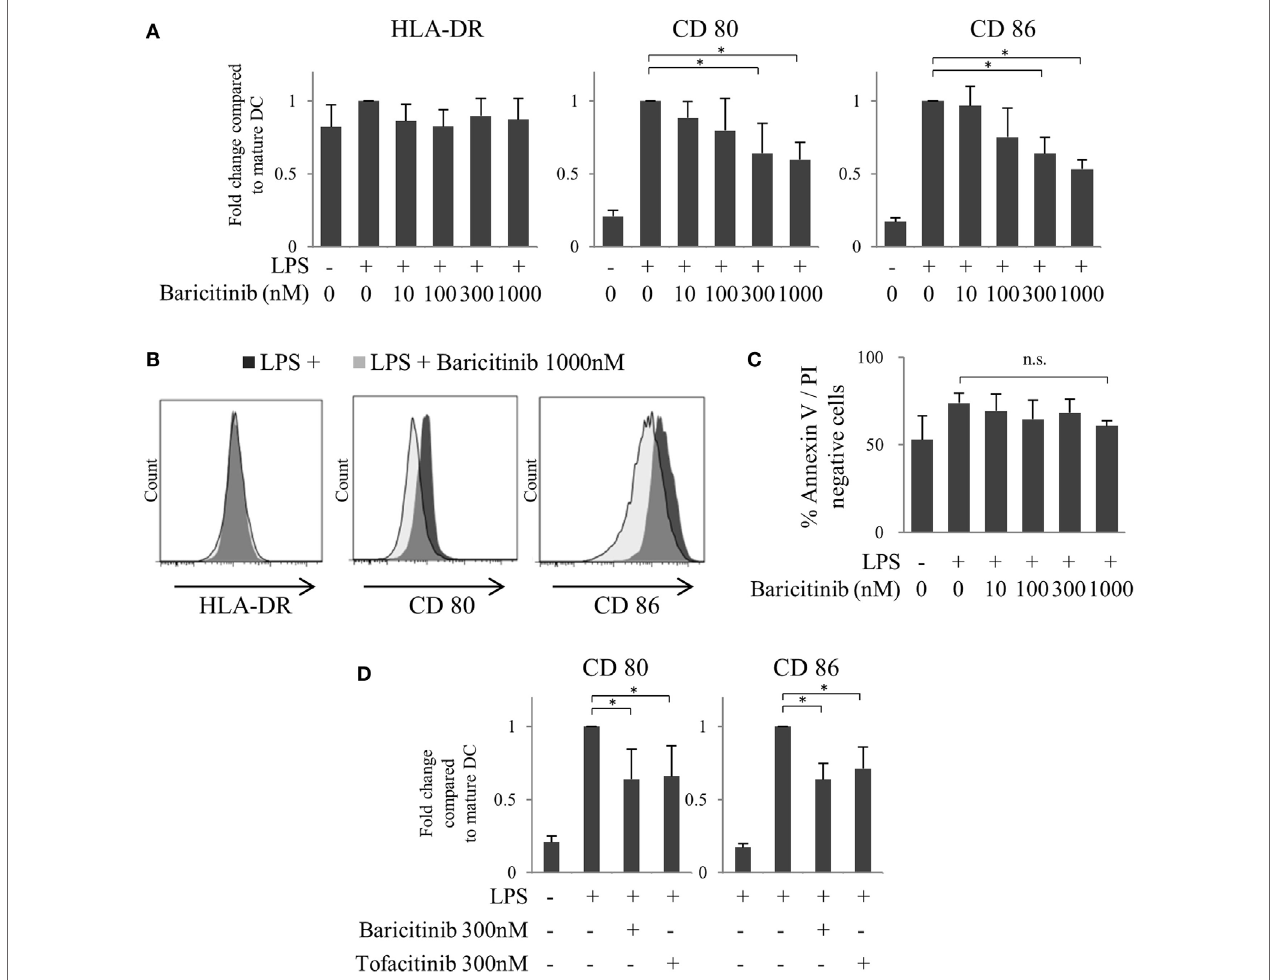
FigUre 2 | Baricitinib suppresses CD80/CD86 expression on dendritic cells (DCs). Immature monocyte-derived dendritic cells were cultured with or without baricitinib and tofacitinib during lipopolysaccharide stimulation for 48 h. The DC phenotype was evaluated using flow cytometry. (a) Expression of HLA-DR, CD80, and CD86. (B) Representative histogram data of HLA-DR, CD80, and CD86 expression. (c) Rate of viable cells (annexin V neg /propidium iodide neg ). (D) Expression of CD80 and CD86 in the presence of baricitinib and tofacitinib. Data are mean ± SD of three different donors per group. * p < 0.05 and ** p < 0.01 (by Student’s t